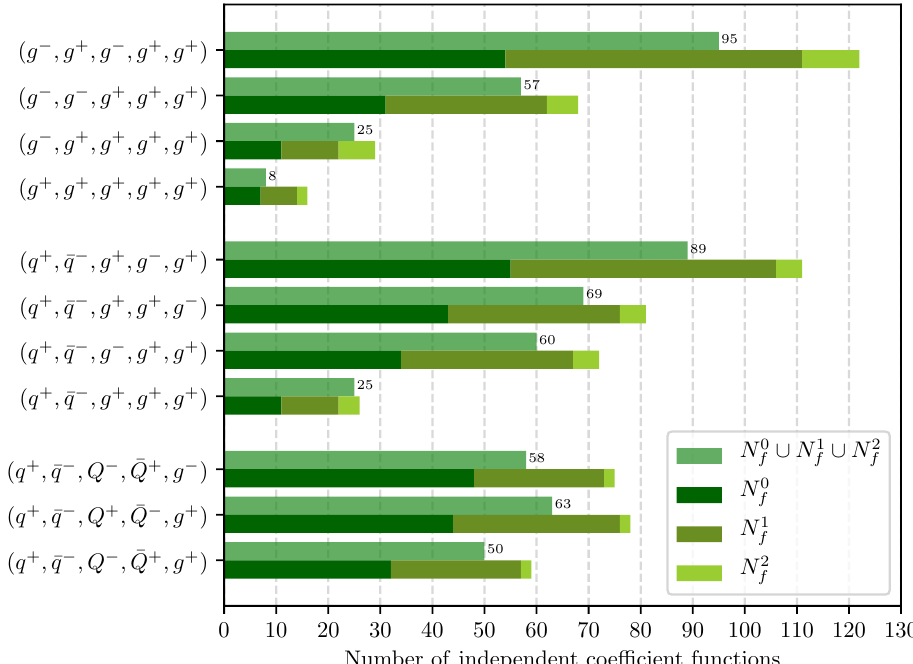
Figure 9 . The number of linearly-independent coe(cid:14)cient functions r (cid:6) plitudes. The three stacked bars display the case when the three di(cid:11)erent N f contributions are considered separately, while the bar labeled N 0 functions when all N f contributions are